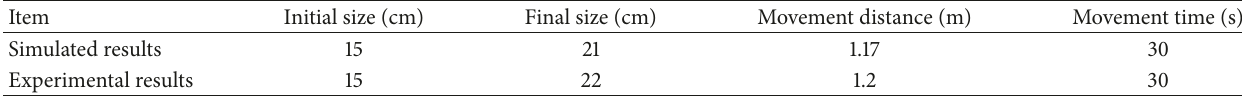
Table 3: Comparison of the simulated and experimental